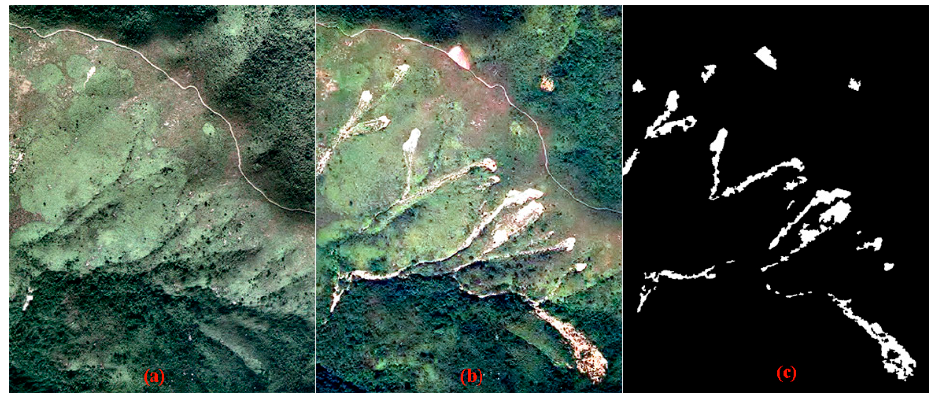
Figure 3. First bi-temporal VHR images: ( a ) pre-event image; ( b ) post-event image; and ( c ) ground reference map.